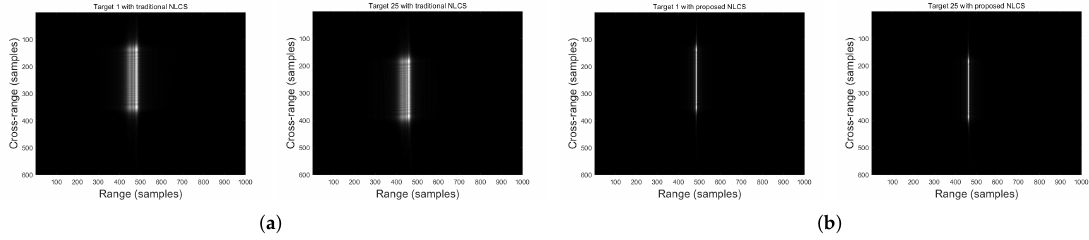
Figure 10. Simulation results of targets 1 and 25 of different NLCS algorithms in the range direction. ( a ) Results of traditional NLCS [41]. ( b ) Results of the proposed